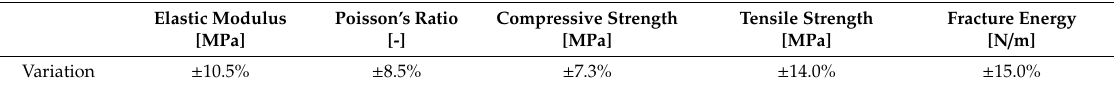
Table 5. Summary of input parameters of AAC used in the sensitivity study [44].